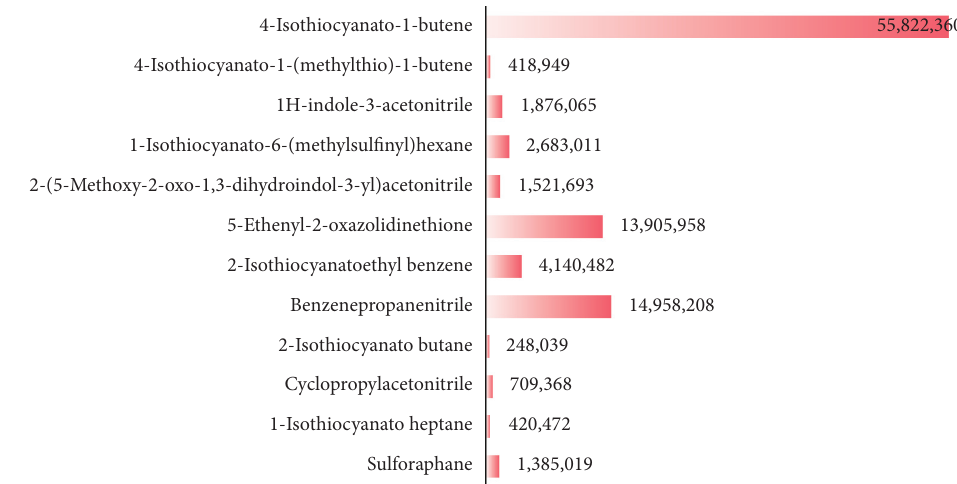
Figure 3: Average area of glucosinolate metabolites in